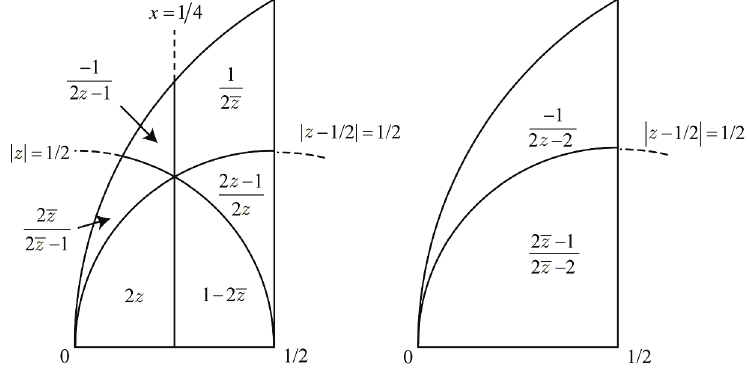
Figure 4. Piecewise functions w L ( z ) (left), and w R ( z ) (right) depending on the position of point z .